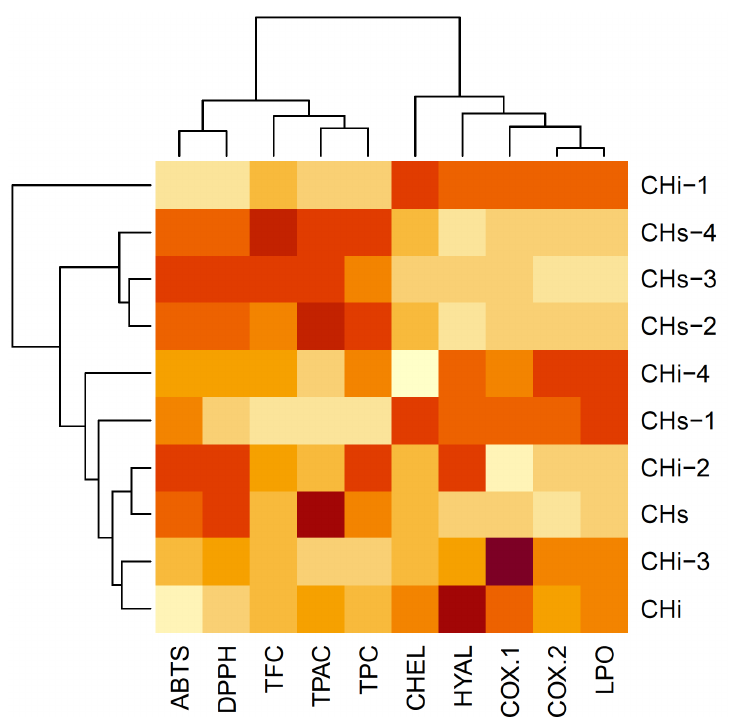
Figure 9. The heatmap analysis of the scaled matrix, with dendrograms based on Euclidean distance. TPC—Total phenolic content; TPCA—Total phenolic acids content; TFC—Total flavonoid content; CHEL—Metal chelating activity; LPO—Lipoxygenase inhibition; HYAL—Hyaluronidase inhibi ‐ tion.